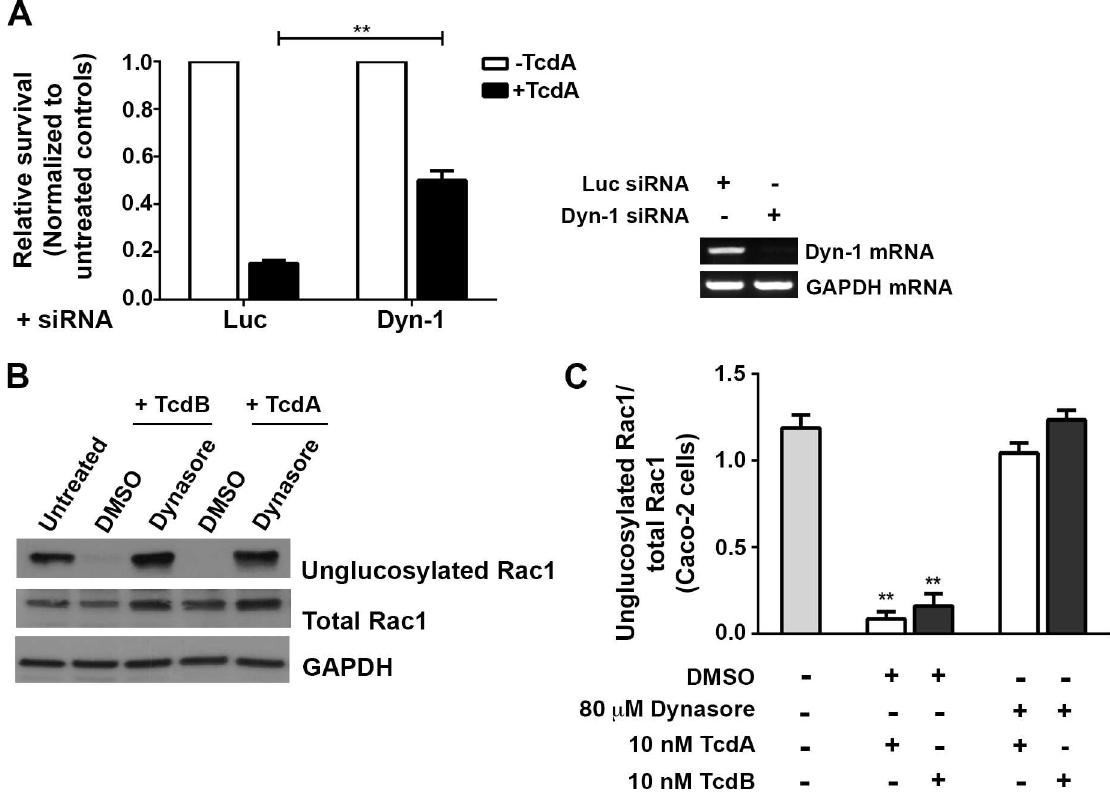
Fig 2. TcdA-induced Rac1 glucosylation and cytotoxicity are dynamin-dependent. (A) Depletion of dynamin-1 confers resistance to TcdA challenge. Caco-2 cells were transfected with 10 nM siRNA againstdynamin-1 (Dyn-1) or luciferase(Luc; non-targeting control) and then intoxicatedwith 50 nM TcdA. ATP levels were determined using CellTiterGlo and normalizedto signal from untreatedcells to assess the relative survival of cells post-toxin treatment. The data represent the averageof four independentexperiments performed in triplicate with the SEM indicatedas error bars. Data were analyzedusing Welch’s t test. ** p < 0.005.RT-PCR confirms that siRNA treatment resulted in a decreasein Dyn-1 mRNA expression. (B) Pharmacological inhibition of dynamin GTPases prevents Rac1 modification by TcdA . Caco-2 monolayers were pretreatedwith either 80 μ M dynasoreor with an equal amount of DMSO control for 1 h at 37˚C. Cells were switched to 4˚C for 1 h and then intoxicatedwith either 10 nM TcdA or TcdB (positive control). Toxins were allowedto bind at 4˚C for 1 h and then internalizeat 37˚C. TcdA and TcdB treated cells were harvestedafter 25 min and 15 min, respectively. Whole cell lysates were preparedfor SDS PAGE and Western blot. The blot was probedwith antibodies against the unglucosylated and total Rac1, and GAPDH. Cells that did not receivetoxin or treatment were used as a control. (C) Four replicatesof the experiments shown in (B) were quantified by densitometry and representedas the ratio of unglucosylated and total Rac1 levels. Results reflect the mean and SEM, and were analyzedusing one-wayANOVA. p-values were generatedusing Dunnett’smultiple comparisons test in GraphPad Prism. ** p <